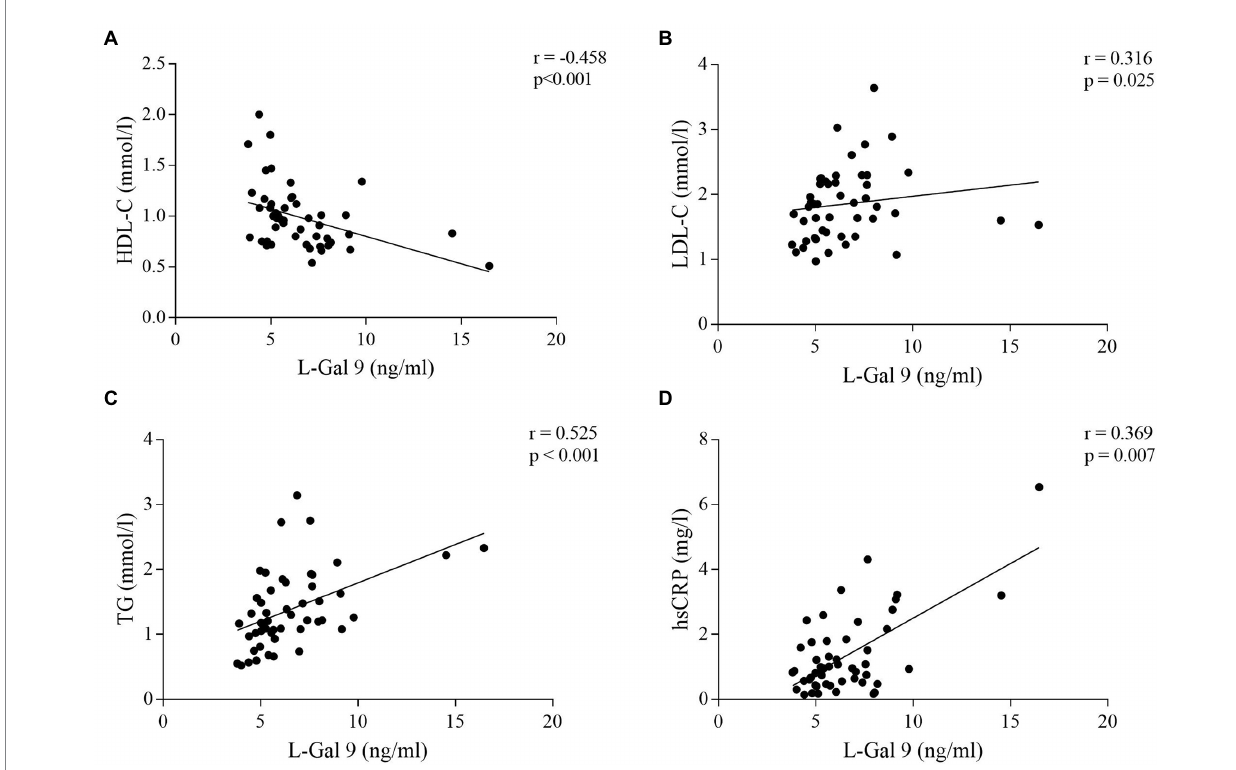
FIGURE 6 Correlations between L-Gal 9 circulating levels and HDL-C (A) , LDL-C (B) , TG (C) , and hsCRP (D) in CHD patients. Spearman ρ analyses were performed and Bonferroni’s correction was applied (6 comparisons; p <